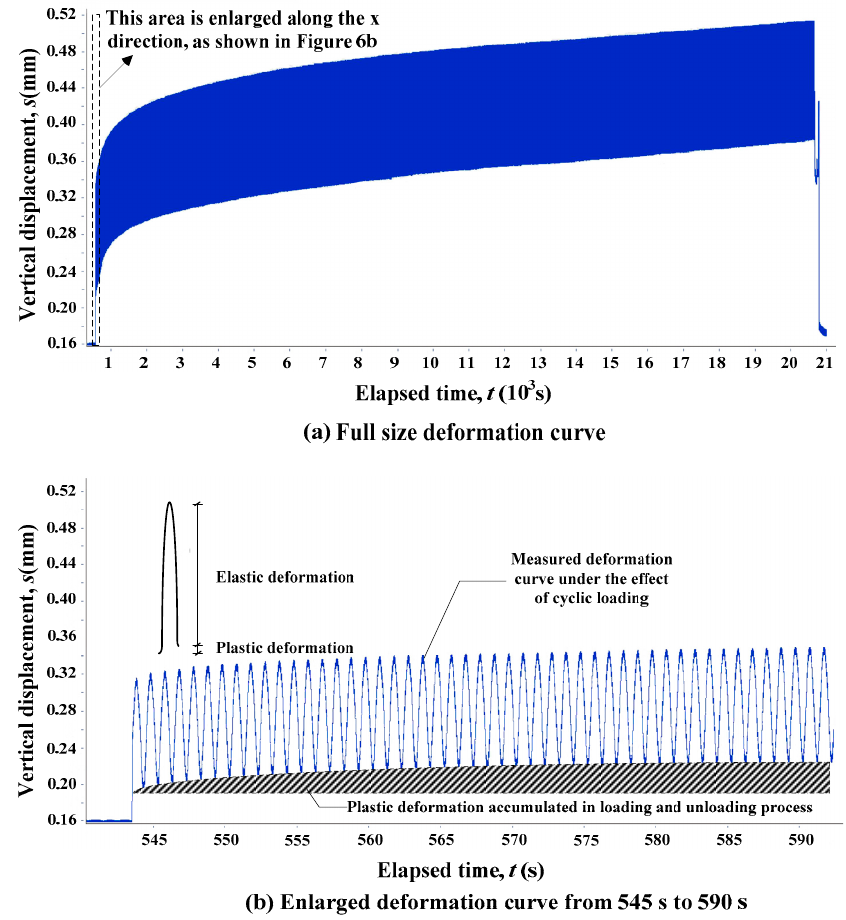
Figure 6. Vertical displacement for Model 3 ( K = 1.0) under 100 kPa cyclic loading level.